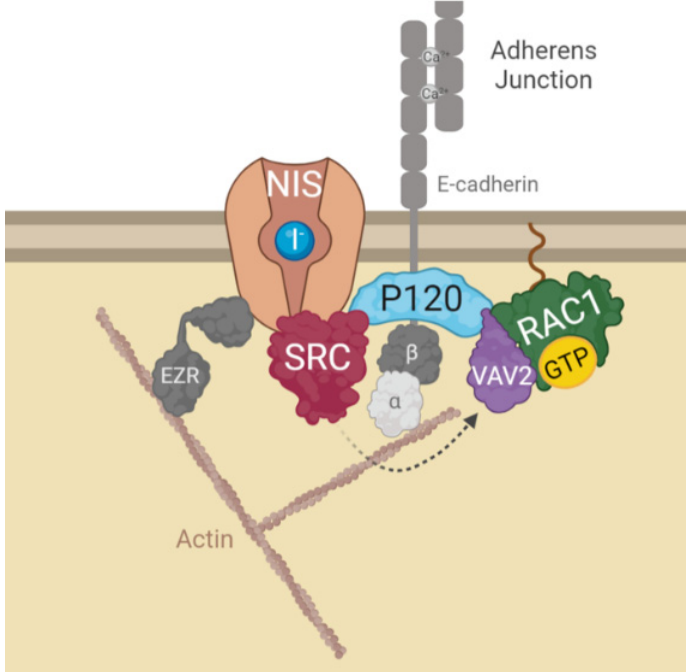
Figure 6. Diagram depicting the model for AJs-derived regulation of NIS functional residency at the PM. In brief, NIS localization and function at the PM depends on its recruitment to AJ complexes at the PM. Interaction of NIS with AJ-localized P120 catenin, allows the assembly of a complex that brings SRC kinase, VAV2 and RAC1 to the correct localization to facilitate the symporter’s retention at the PM. SRC-mediated phosphorylation of the RAC1 GDP/GTP exchange factor VAV2 promotes activation of the small GTPase RAC1 in the vicinity of NIS. RAC1 signaling induces de novo F-actin polymerization and ezrin activation [10], which facilitates the symporter’s functional stabilization at the PM anchoring it to the actin cytoskeleton (see text for further details). The figure was created with BioRender.com, accessed on 26 July 2022.